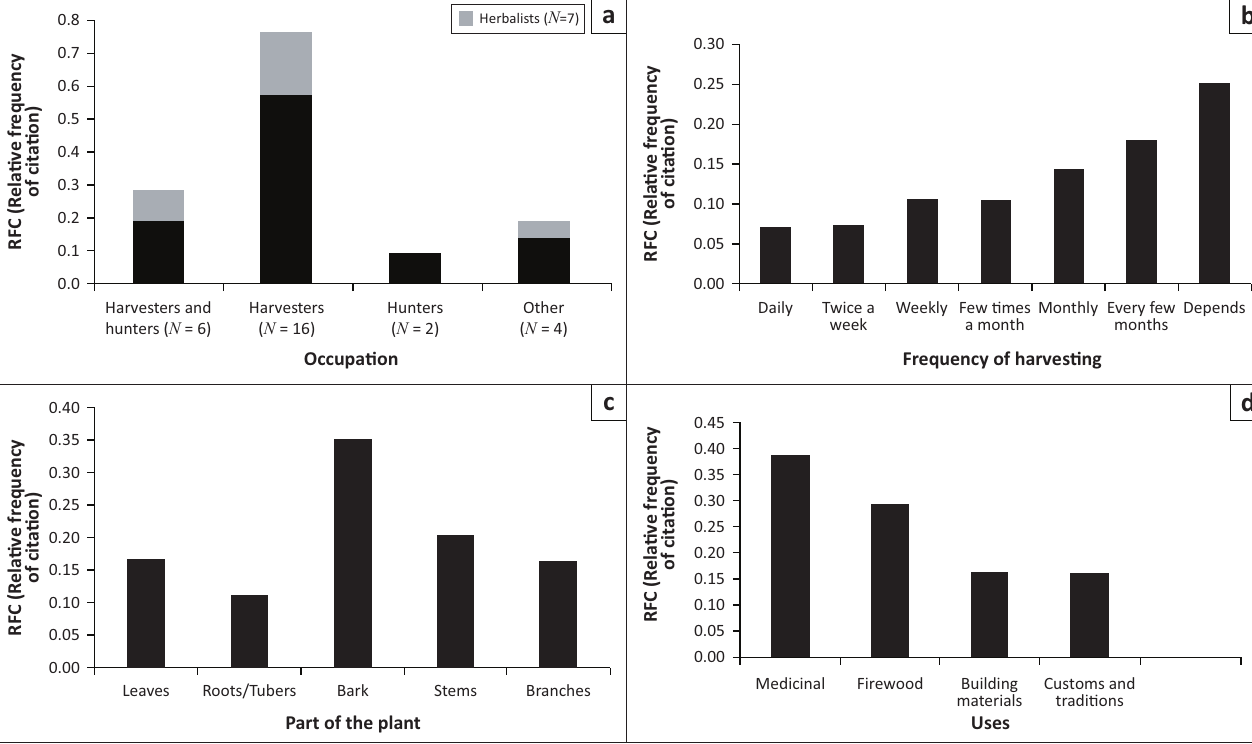
FIGURE 3: (a) The occupation of the participants, (b) the frequency of harvesting by participants, (c) the relative frequency of citation of the plant parts used by participants and (d) the RFC of the uses of the plants described by harvesters near the Pirie forest.